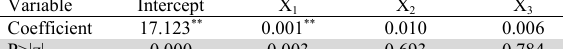
Results of the coefficient estimation